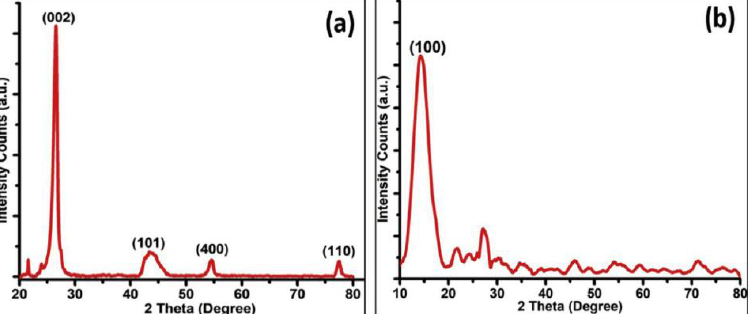
Figure 10. XRD spectrum for ( a ) graphene and ( b ) graphene oxide. Reprinted with permission from Ref. [63]. 2019, Elsevier.